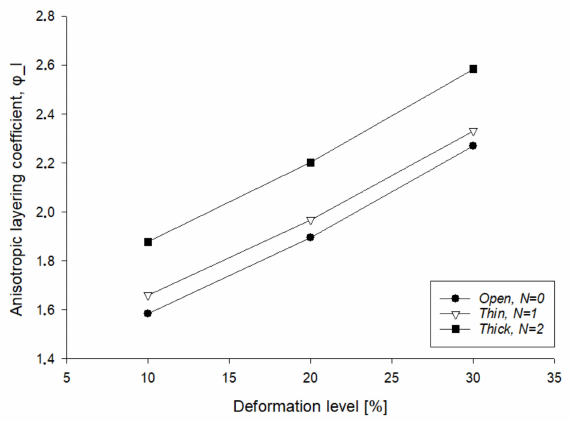
Figure 13. Anisotropic layering factor trend for each configuration.